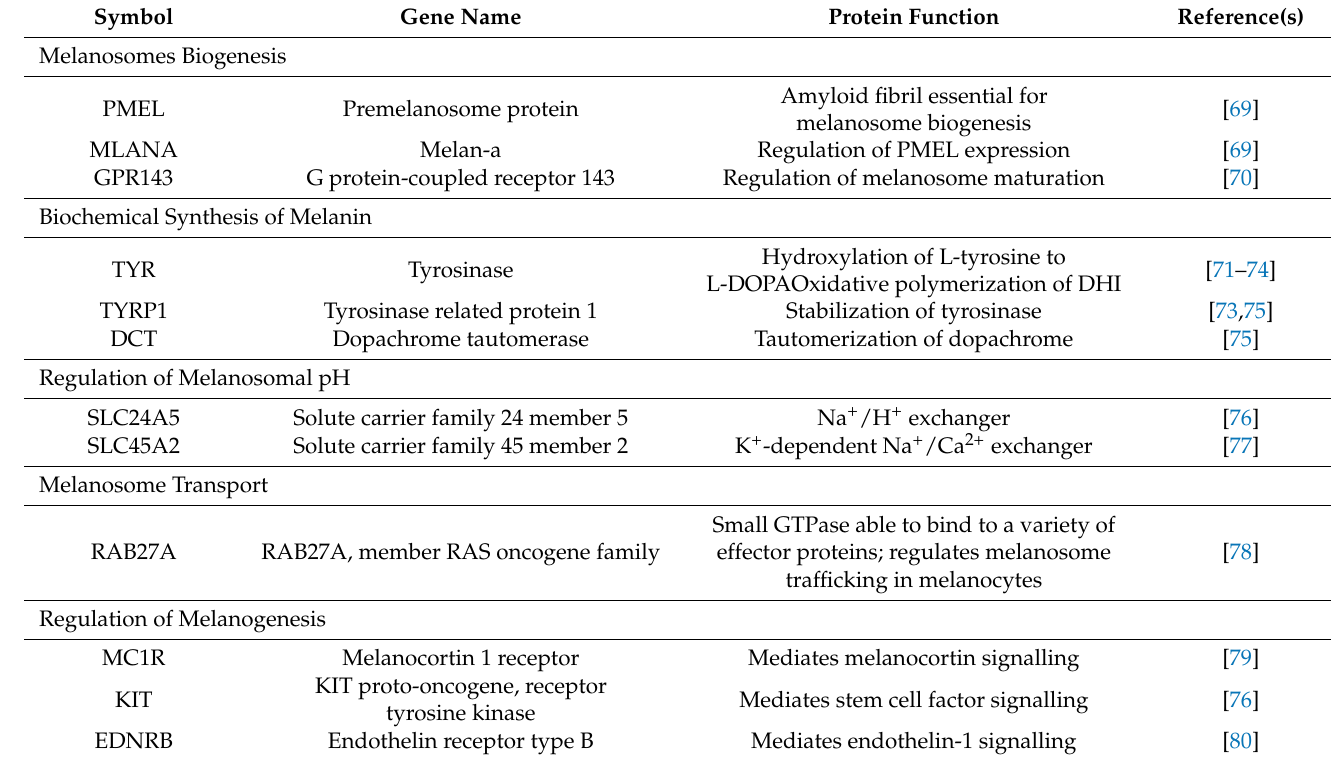
Table 1. Most representative genes involved in the pigmentary process, with expression controlled by the transcription factor MITF. DHI: 5,6-dihydroxyindole; L-DOPA: